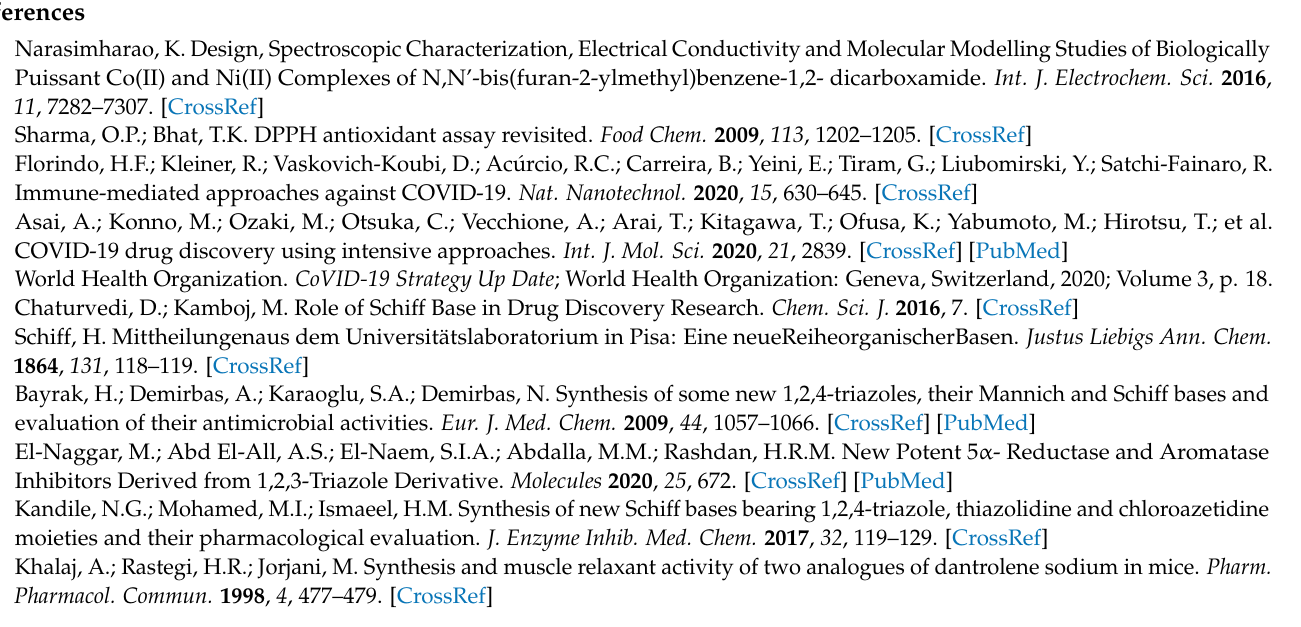
5a ; Figure S3: 1 H NMR of Compound 5b ; Figure S4: 13 C NMR of Compound 5b ; Figure S5: 19 F NMR of Compound 5b ; Figure S6: 1 H NMR of Compound 5e ; Figure S7: 13 C NMR of Compound 5e ; Figure S8: 1 H NMR of Compound 5f ; Figure S9: 13 C NMR of Compound 5f ; Figure S10: Ligand N3 was the only one that showed interaction with